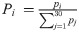
Ligand binding site predictions at atom-based level.(a) The prediction accuracies for the 30 ANN_BAGGING models (x-axis) trained with different subsets of the 54 attributes (Table 1) are evaluated with MCCs (y-axis). For each of the ANN_BAGGING models, 8 different combinations of the 54 attributes were used as input sets for machine learning algorithm: PLWG-attributes 1~54; PLW-attributes 1~53; PWG-attributes 1~31 and 54; LWG-attributes 31~54; LW- attributes 31~53; LG-attributes 32~54; L-attributes 32~53; P-attributes 1~30. (b) The correlation of the normalized prediction confidence level of protein surface atoms (x-axis) to the average distance (organ squares with standard deviations) from the protein surface atoms to the corresponding ligands (right-hand side y-axis) is shown by the linear fitting of the data points (R2 = 0.89). The blue histogram shows the distributions of the protein surface atoms in log10 scale (left-hand side y-axis) for each prediction confidence level range. (c) The Pearson’s correlation coefficients (PCCs) between attribute values and prediction confidence levels are shown in the y-axis. The PCCs between attribute values and LBS assignments are shown in the x-axis. The interacting protein atom types are labelled in black; the interacting ligand atom types are labelled in red; the interacting water atom type is labelled in purple; and the geometry attribute is labelled in blue. See text for discussion. (d) Distribution of protein atom types (x-axis) in the predicted atom-based ligand binding sites in proteins is shown by the histogram. The percentage Pi (shown in the y-axis) for the atom type i is calculated by the equation below: Pi =pi∑j=130pj, where pi=niNi
Ni is the total number of atom type i in the dataset, while ni is the number of atom type i with prediction confidence level greater than 10%. The dashed line in the figure represents the baseline (Pi = 1/30) for random predictions. The data shown in the panels (a) to (d) were calculated with the predictions in the 10-fold cross validation on the S5010 dataset.